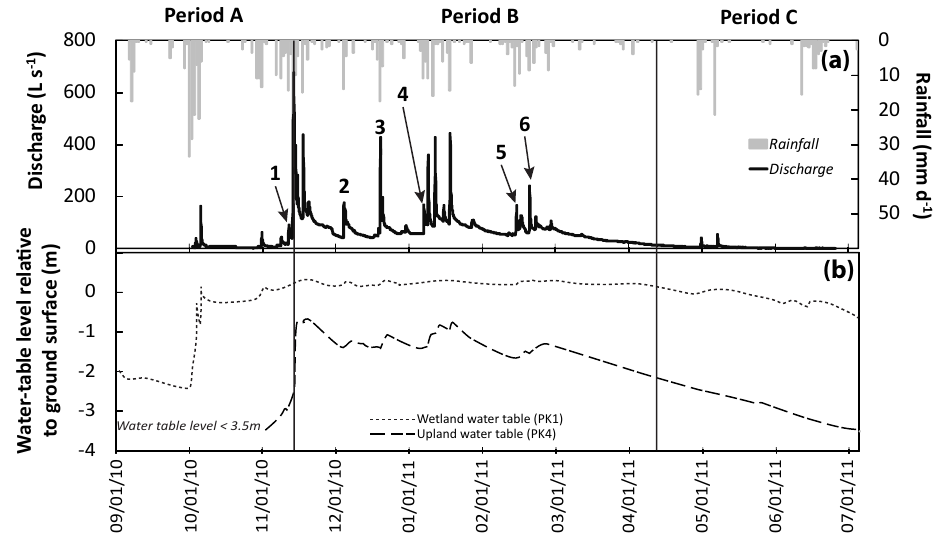
Figure 3. (a) Record of hourly discharge and daily rainfall and (b) record of hourly water table levels in the wetland (PK1) and upland (PK4) domains during the investigated periods. Monitored storm events are indicated by